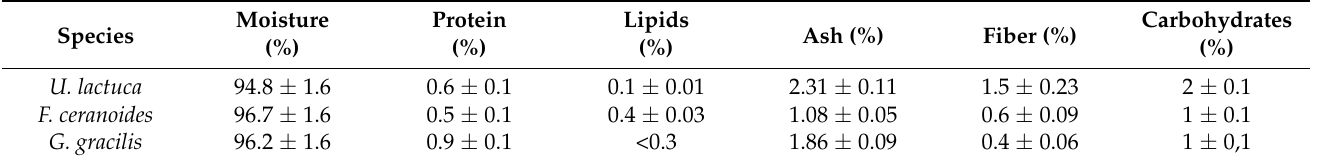
Table 1. Composition of seaweeds (%) used in the AEs preparation. Moisture Species